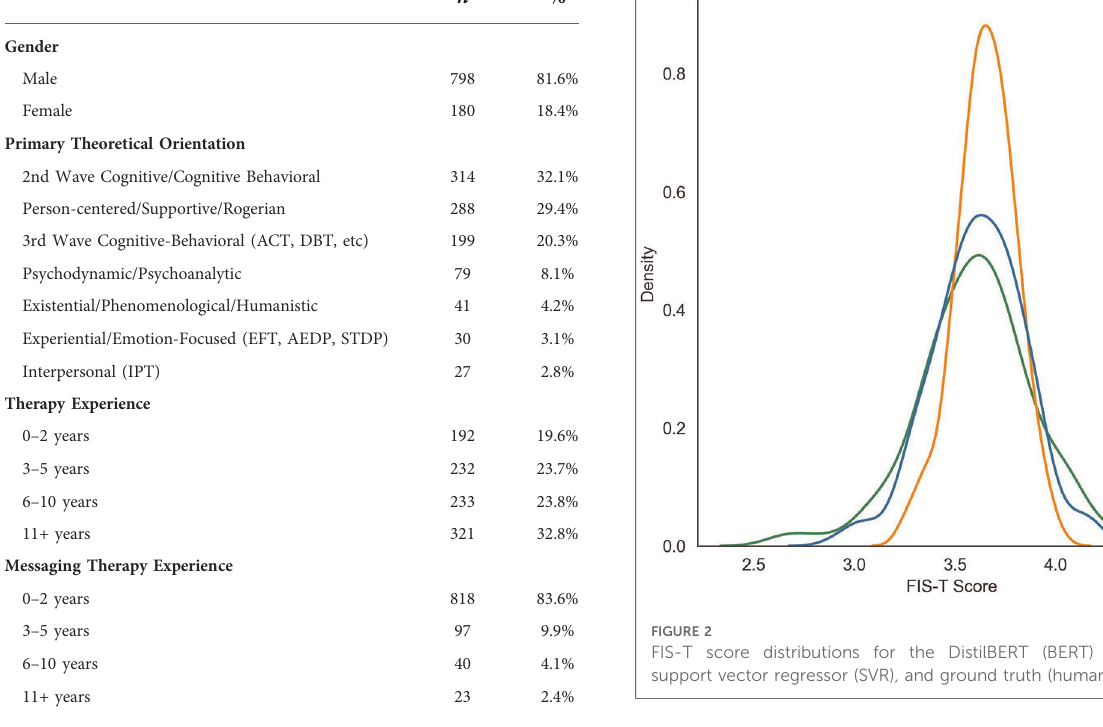
TABLE 2 Demographics of participating therapists ( n =978).